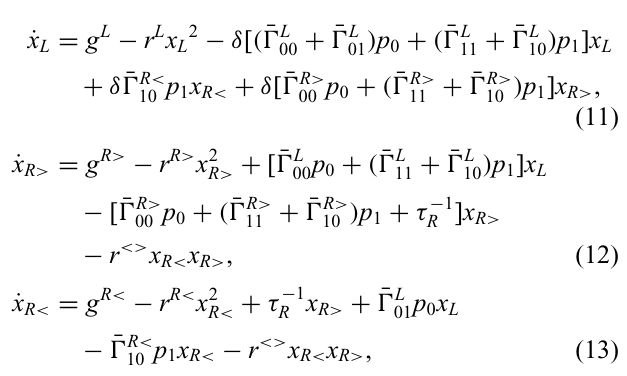
FIG. 3. Representations of the processes involving quasi- particles. (a)–(c) Processes conserving the total quasi- particle number entering the equations for (a) x L [Eq. (11)], (b) x R > [Eq. (12)], and (c) x R < [Eq. (13)]. The horizontal arrows depict parity-switching transitions, the upward diagonal arrows qubit relaxation, and the downward diagonal arrows qubit excitation; the downward vertical wavy arrows account for quasiparticle relaxation by phonon emission. (d)–(f) Processes associated with generation (upward arrows) due to pair-breaking photons (wavy arrows) or recombination (downward arrows) of quasipar- ticles entering the equations for (d) x L , (e) x R > , and (f) x R <